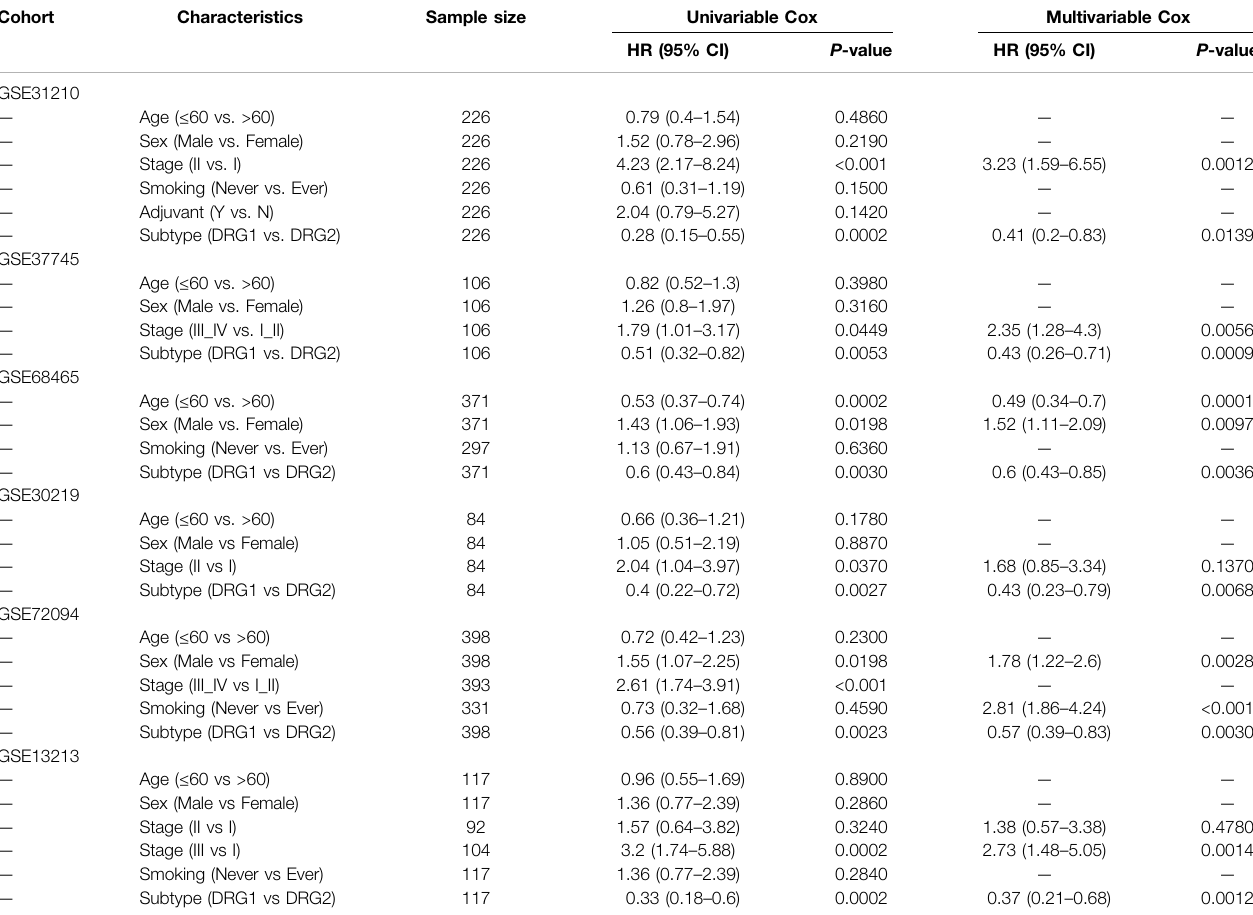
TABLE 2 | Univariable analysis and multivariable Cox regression analyses of OS in six validation cohorts. Cohort